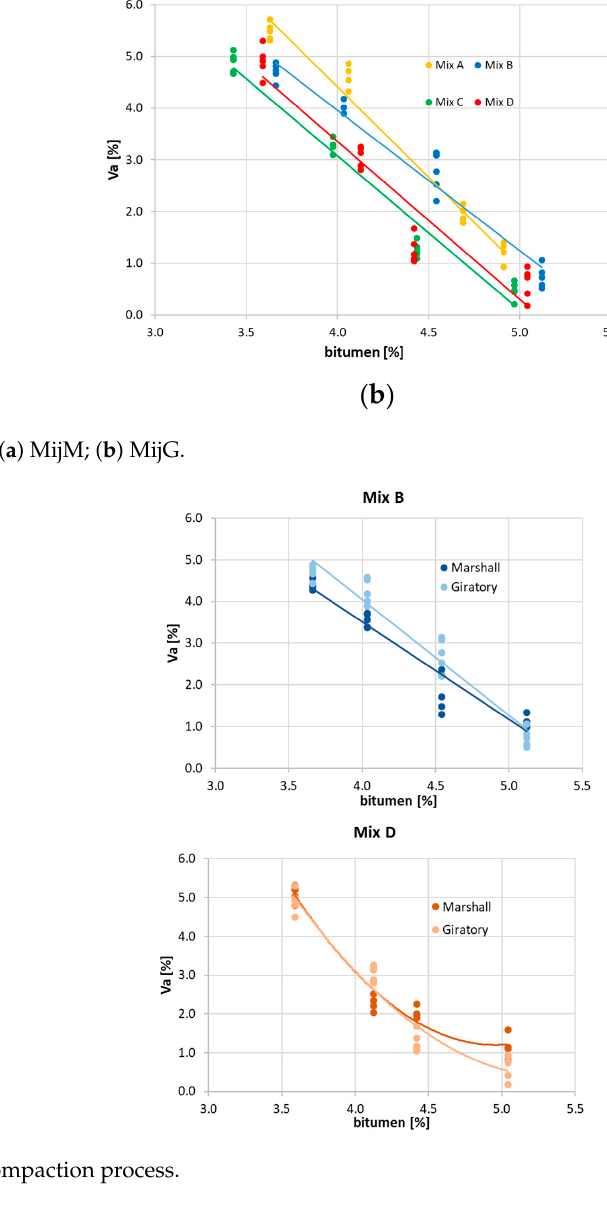
(d) Figure 5. Mijk stability. ( a ) MAjk; ( b ) MBjk; ( c ) MCjk; ( d ) MDjk.